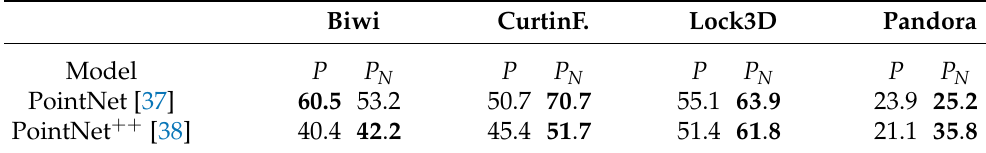
ResNet [4] 51.7 Table 4. Intra-dataset results, in terms of recognition accuracy, using point clouds P . P N represents the normalized point cloud computed while using Equation (6), as detailed in Section 3.5. Biwi CurtinF.